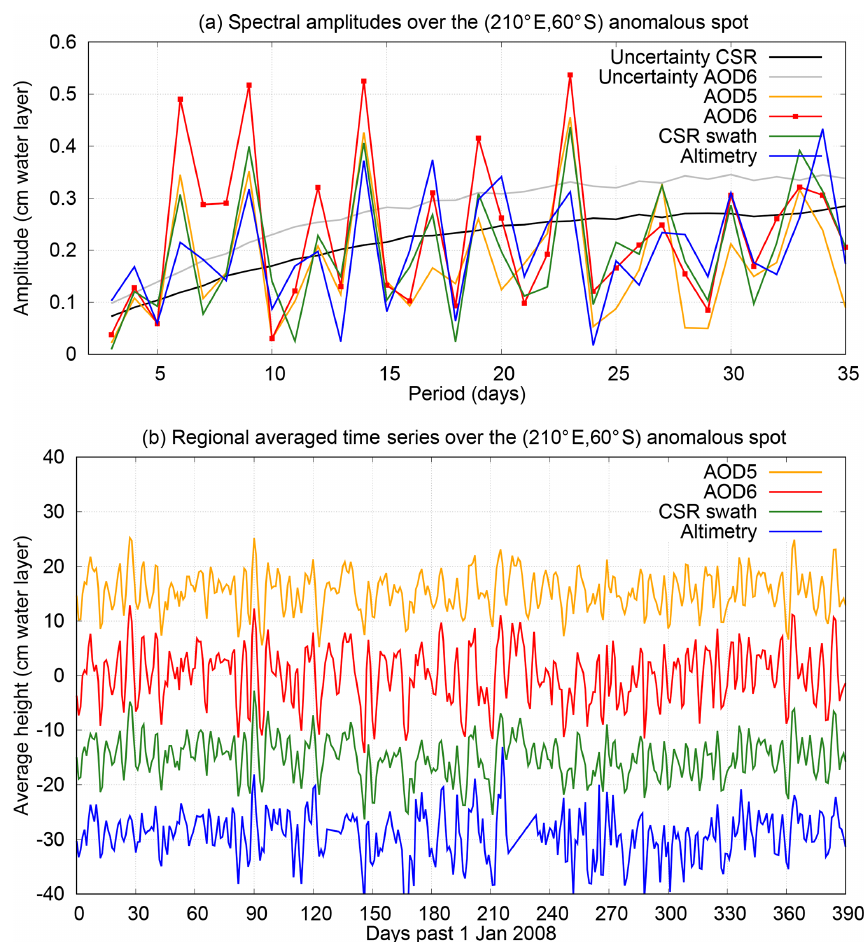
Figure 5. Example time series (a) and spectral amplitude plot over the AOD6 anomalous spot (near 210 ◦ E, 60 ◦ S), with lines offset for clarity. Spectral analysis (b) was computed for the time span 2003–2013. The black line shows the uncertainty for the CSR swath series (which is similar to the AOD5 and altimetry uncertainties), and the grey line shows the uncertainty for the AOD6 series. Signals below these lines are not statistically